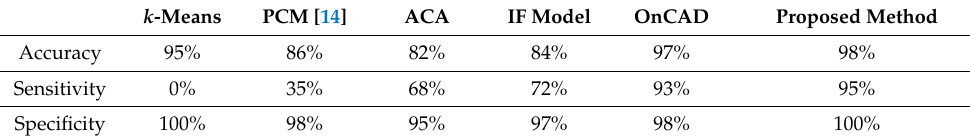
Table 2. Comparative analysis using KDDCUP’99 in terms of different parameters.